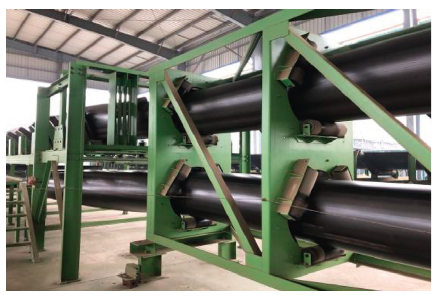
Figure 1: The pipe conveyor.